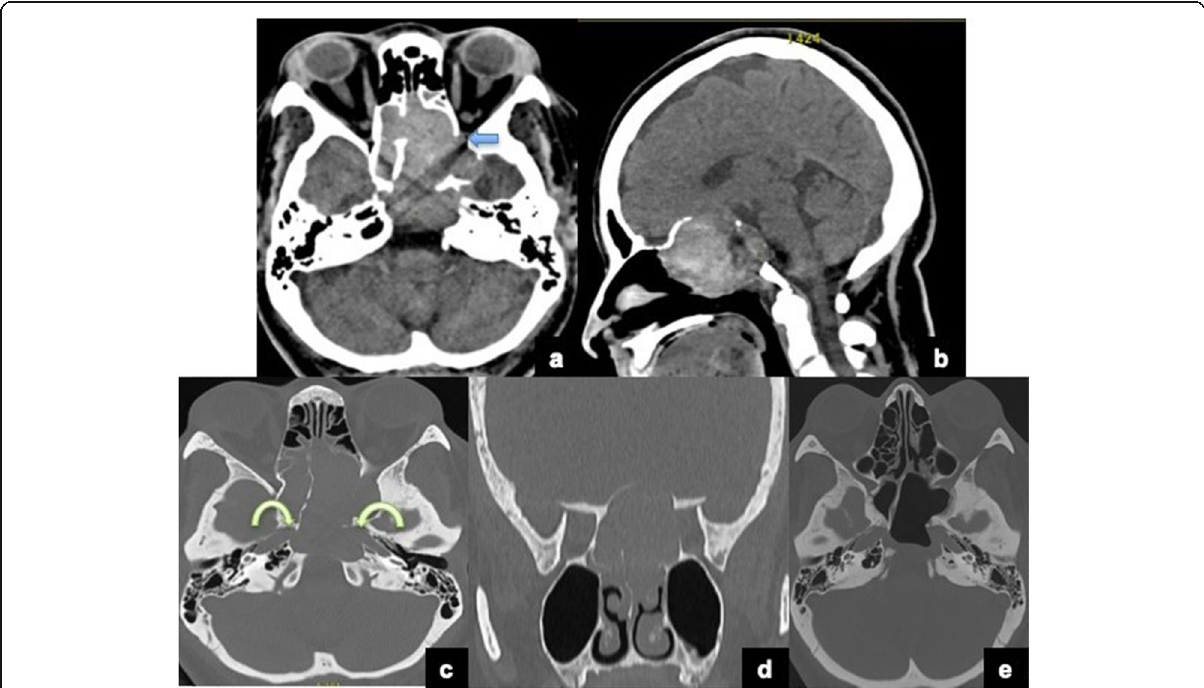
Fig. 1 a , b Computed tomography axial and sagittal images without contrast show hyper dense soft tissue in the expanded sphenoid sinus; its pneumatized portion of greater wing of sphenoid bones, clivus, and posterior ethmoid air cells. There is extension of soft tissue at the left orbital apex (blue arrow). Extension of lesion into sella is seen. Plain CT axial ( c ) and coronal bone window images ( d ) show completely thinned out and remodeled surrounding bony walls due to pressure necrosis. Complete rarified medial wall of bilateral internal carotid artery canals also seen (yellow arrows). e Post-operative axial bone window CT image shows air filled sinus cavity with absence of soft